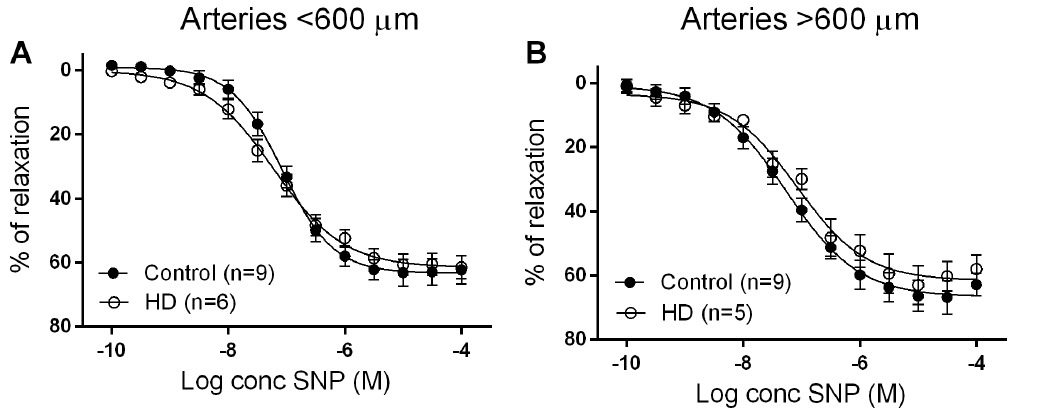
Fig. 4. Concentration-response curves to sodium nitroprusside in arteries obtained from HD patients and controls. Data are expressed as mean ¡ SEM and the comparison is by student’s t-test. HD, haemodialysis; n, number of arteries; M,